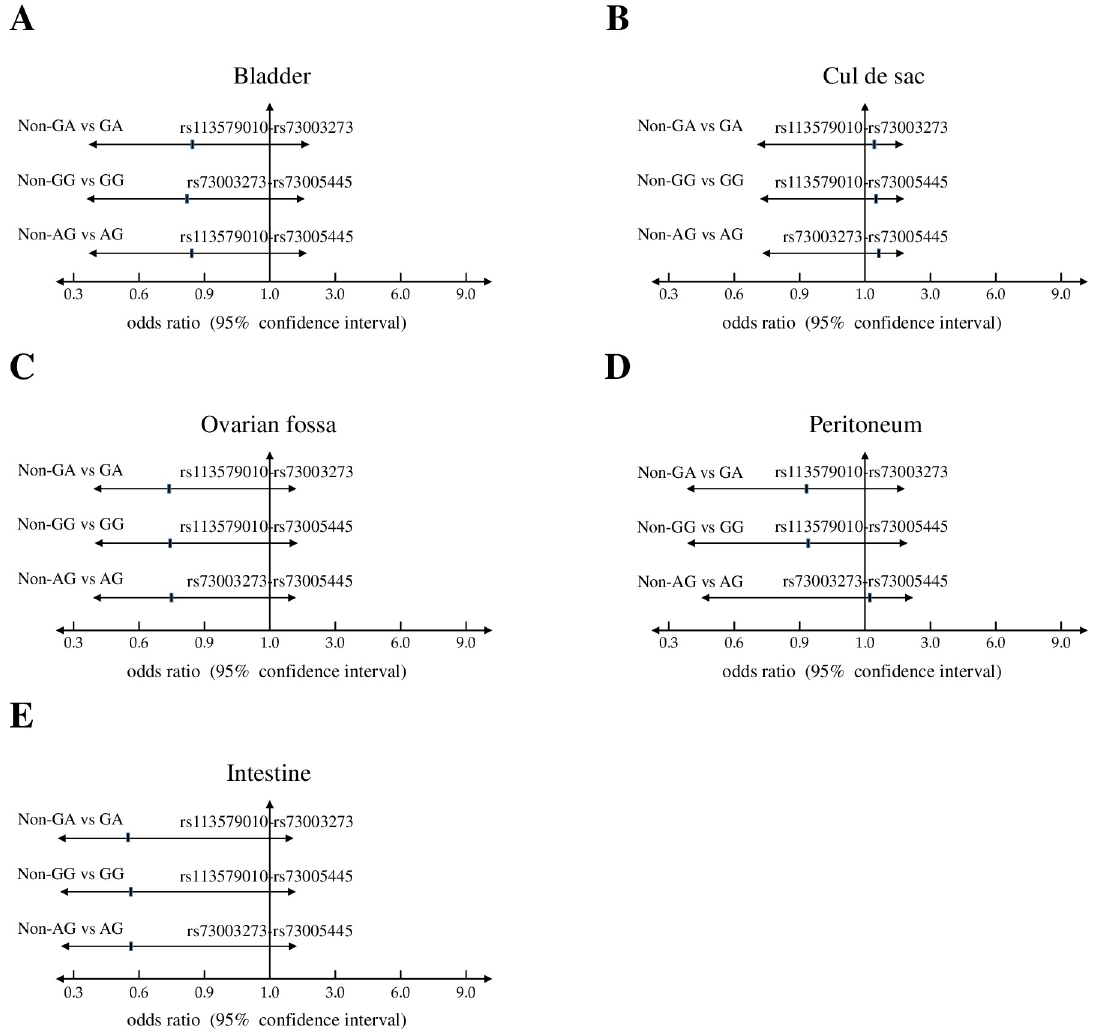
Fig 2. Haplotype analyses of selected functional SNPs in UCA1 and their associations with adhesion sites of endometriotic lesions. Odds ratios and 95% confidence intervals of three risk haplotypes based on adhesion sites, including ( A ) bladder; ( B ) cul de sac; ( C ) ovarian fossa; ( D ) peritoneum; and ( D )